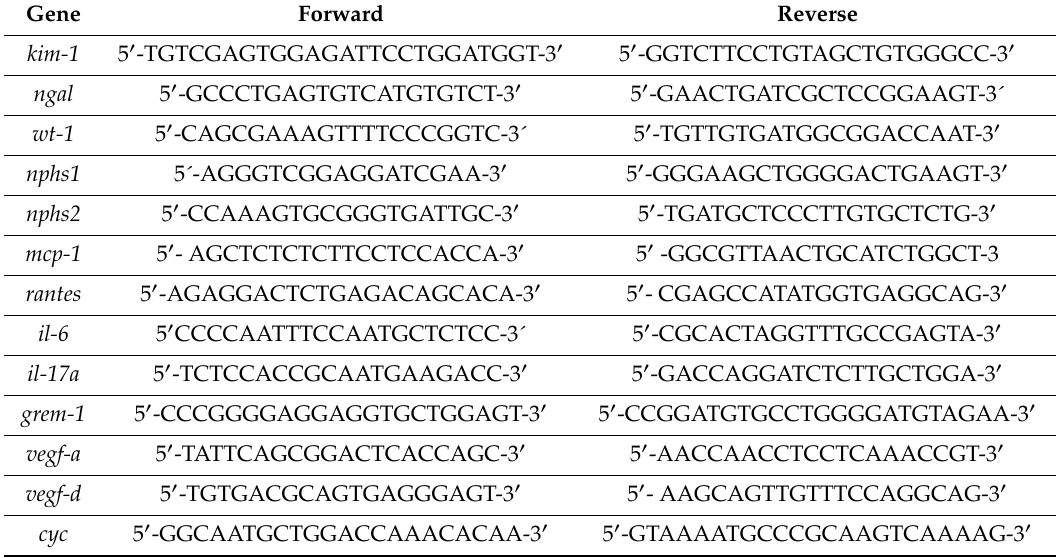
Table 1. Primers used for quantitative polymerase chain